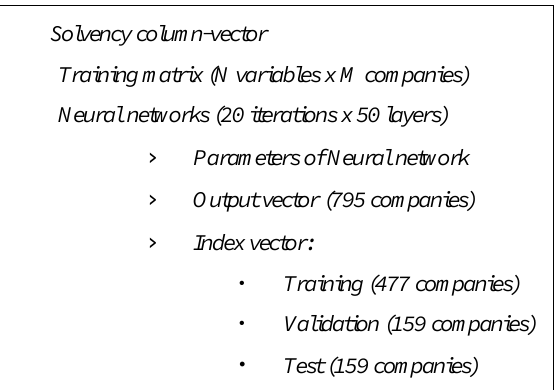
Table 7. NN structure.